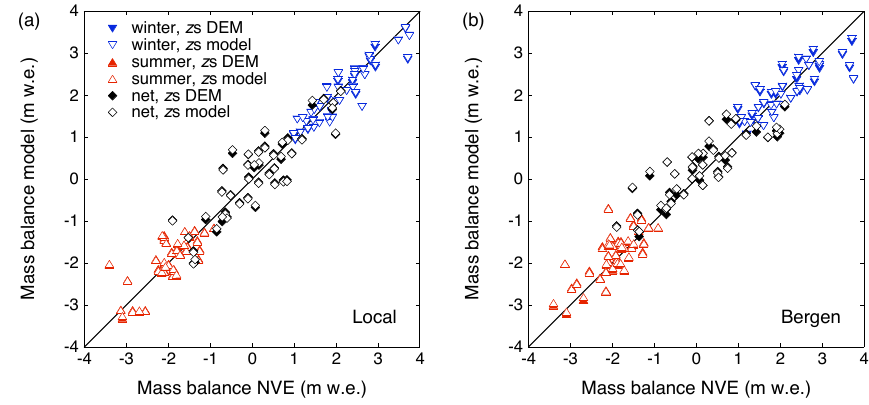
Fig. 6. Basin-averaged measured (NVE) and modelled winter, summer and net mass balance for Rembesdalsskåka for all 43 years in the period 1963–2005, using the input data from local stations and Bergen. Mass balances were calculated for a fixed topography ( z s DEM) and the modelled topography from the 20th century run ( z s model).